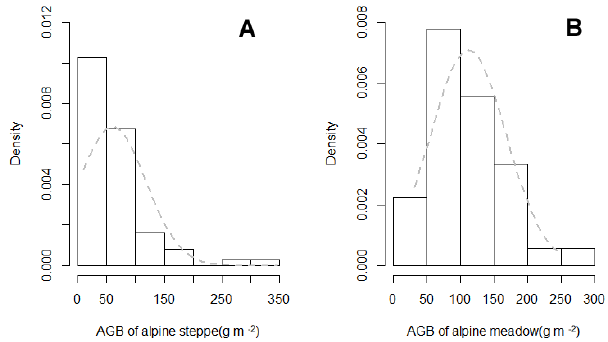
Fig. 4. Density distribution curves of the AGB of samples collected in the alpine steppe (A) and the alpine meadow (B) of the Tibetan Plateau from 2001 to 2005. All designations are the same as those in the footnotes below Table 1.